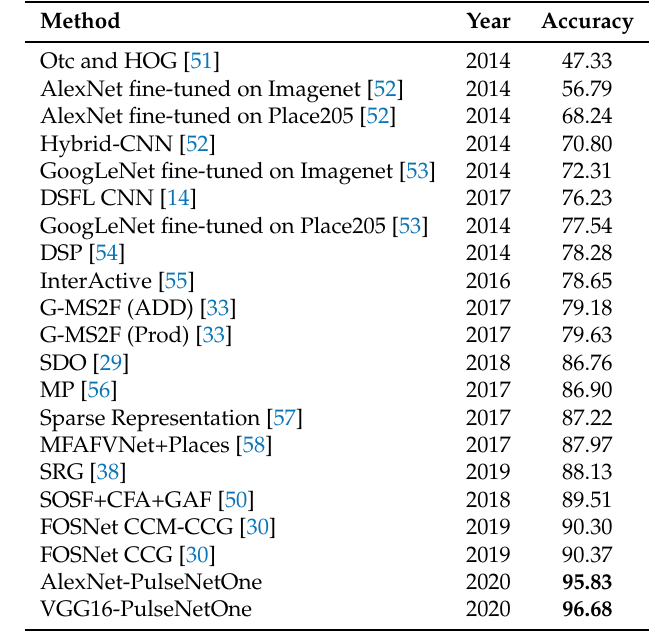
Table 5. A comparison between state-of-the-art and PulseNetOne results on the MIT67 data set. The entries in bold show the method with the best classification for the network.